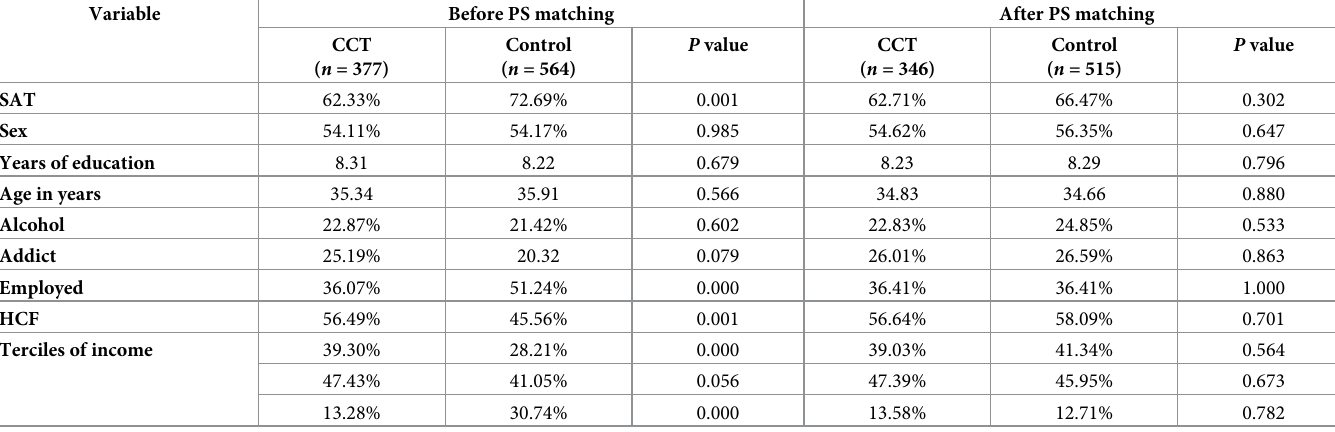
Table 4. Comparison of patient characteristics between CCT and control groups before and after PS matching.